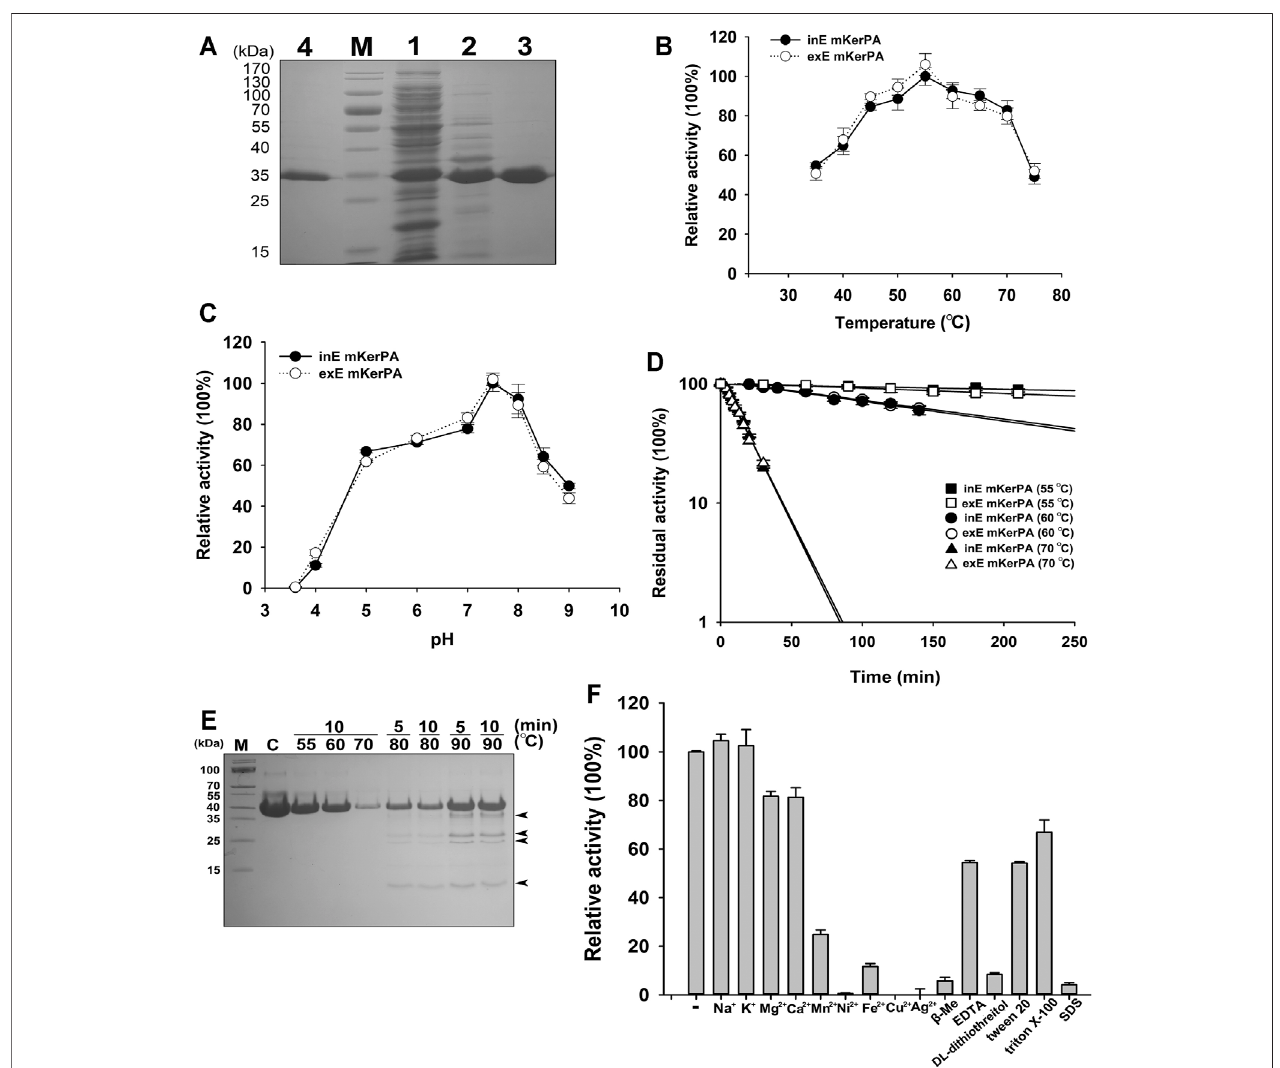
FIGURE 2 | Enzymic properties of recombinant keratinase from Pseudomonas aeruginosa (KerPA). (A) SDS-PAGE analysis of puri fi cation procedures for recombinant KerBL. M, protein markers; Lane 1, supernatant of total cell extract of Escherichia coli Origami ™ (DE)pLysS harbouring pET22b- KerPA ; Lane 2, sample from Lane 1 after heat treatment at 50 ° C for 1 h; Lane 3, samples from Lane 2 puri fi ed using Ni 2+ -charged chelating Sepharose Fast Flow column; Lane 4, puri fi ed samples from culture supernatant of E. coli C321 Δ A exp.T7 harbouring pET26b- KerPA . (B) Effect of temperature on enzymic activity of KerPA. Samples of intracellularlyexpressed KerPA(inEmKerPA)andextracellularlyexpressedKerPA(exEmKerPA)enzymesincubated with2.5 g/Lazocaseininphosphate buffer(PB,pH 7.5) at various temperatures for 10 min. Activities at an optimal temperature (55 ° C) were de fi ned as 100%. (C) Effect of pH on enzymic activities of inE KerPA and exE mKerPA.EnzymeactivitywasassayedatdifferentpH,andthehighestactivitywasde fi nedas100%. (D) Heatinactivationpro fi lesofinEKerPAandexEmKerPA.Enzyme samples were incubated at 55, 60, and 70 ° C for indicated times and assayed for residual activity using azocasein as substrate at 55 ° C. (E) SDS-PAGE analysis of samples of inE KerPA enzyme incubated at different temperatures. Autocleavage products are indicated with black arrowheads. (F) Effects of metal ions and chemical reagentsonactivityofinEKerPA.AzocaseinolyticactivityofinEKerPAinthepresenceofdifferentmetalionsandchemicalreagentswasassayedafterincubationat55 ° C for 10 min. Activities of control group were de fi ned as 100%. Values are means ± Standard Deviation (SD) of three independent